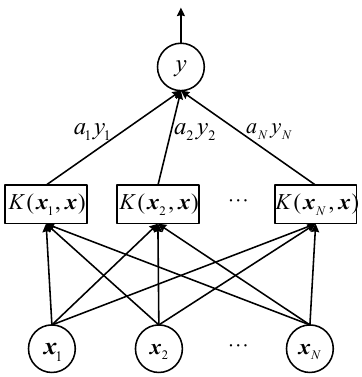
Figure 1. Support Vector Machine (SVM) algorithm structure: the feature vectors are input parameters and the target is the output parameter.